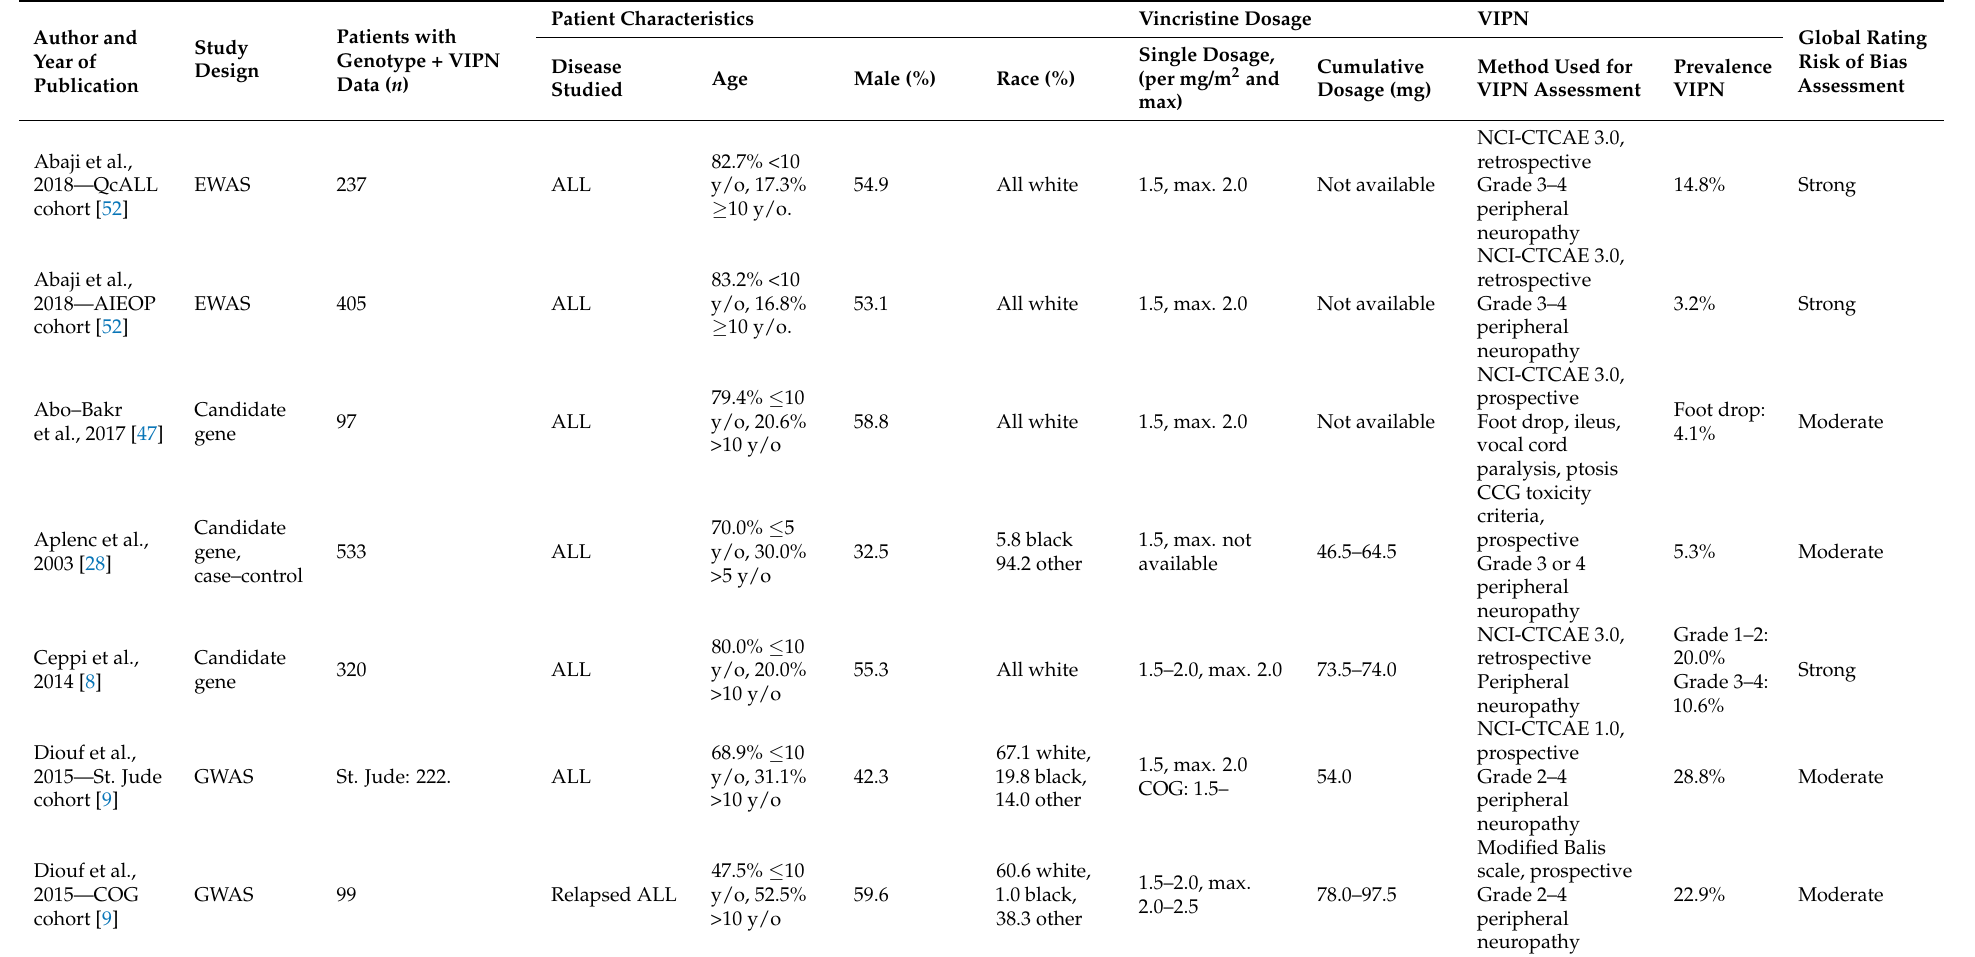
Table 1. Sociodemographic and clinical characteristics of studies included in the systematic